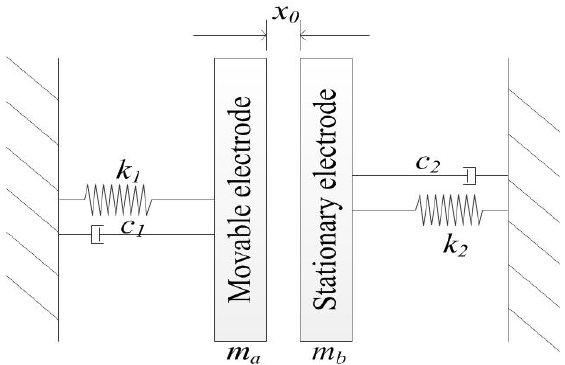
Figure 3. The physical model of the inertial micro-switch.